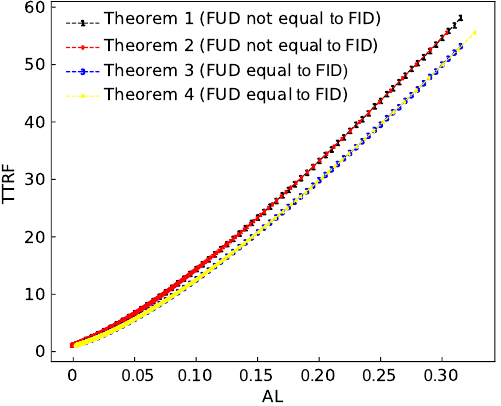
Fig. 8 Plots based on optimal